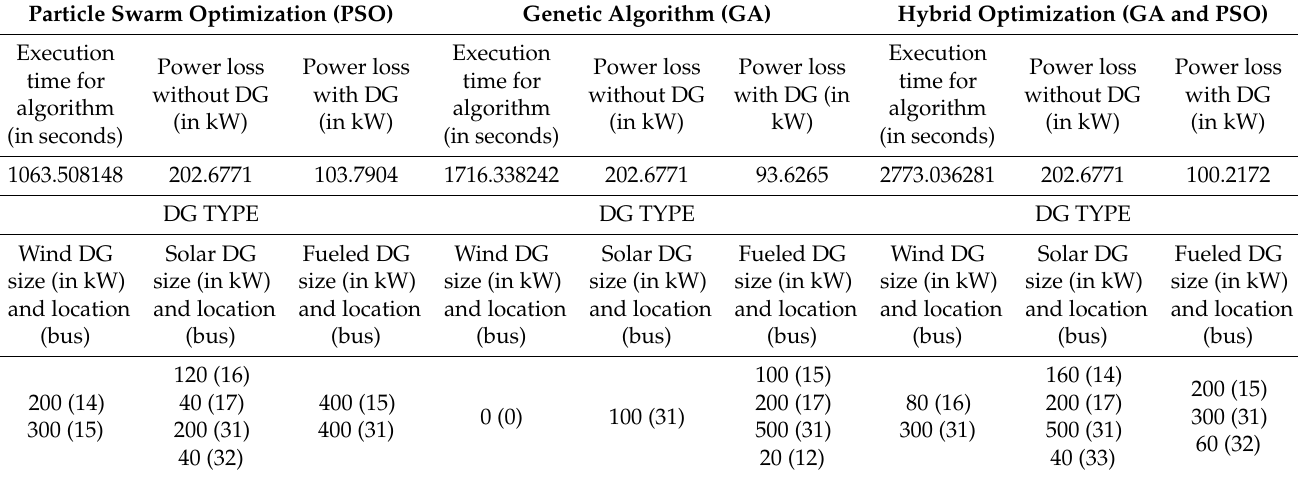
Table 11. Results for optimal DG sizes and their corresponding optimum location using MCS for scenario-3 using different metaheuristic optimization techniques. Particle Swarm Optimization (PSO) Genetic Algorithm (GA) Hybrid Optimization (GA and